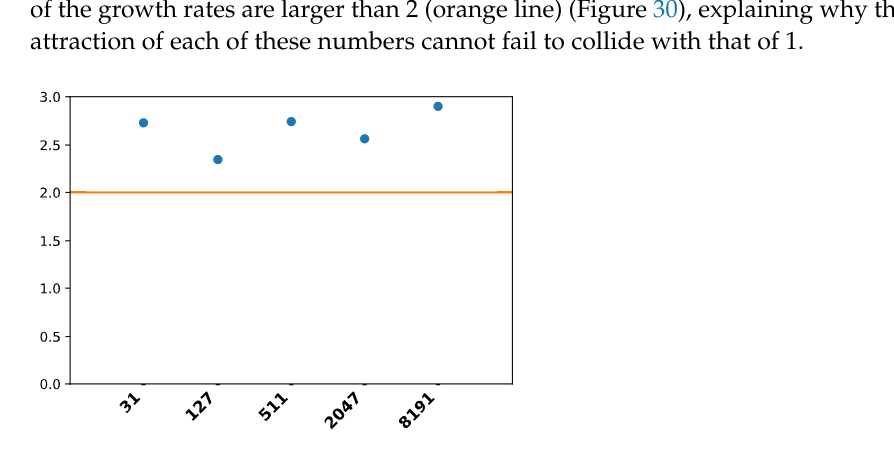
Figure 30. The observed growth rates of the basin of attraction of different Mersenne numbers, with 2 in orange for